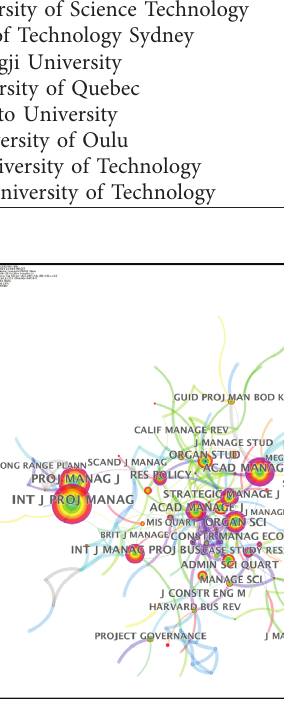
Figure 7: Network of journal